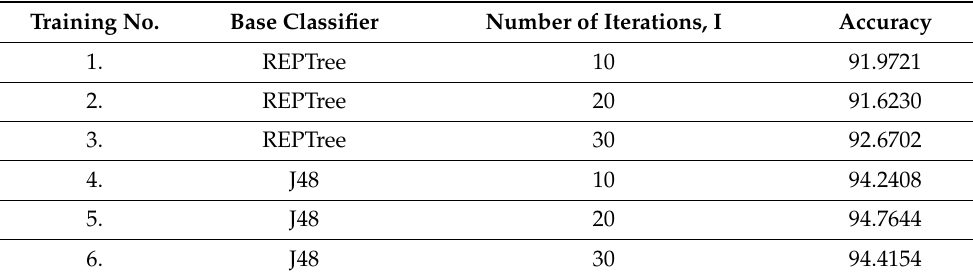
Table 12. Prediction accuracy of bagging hyperparameter optimization. Training